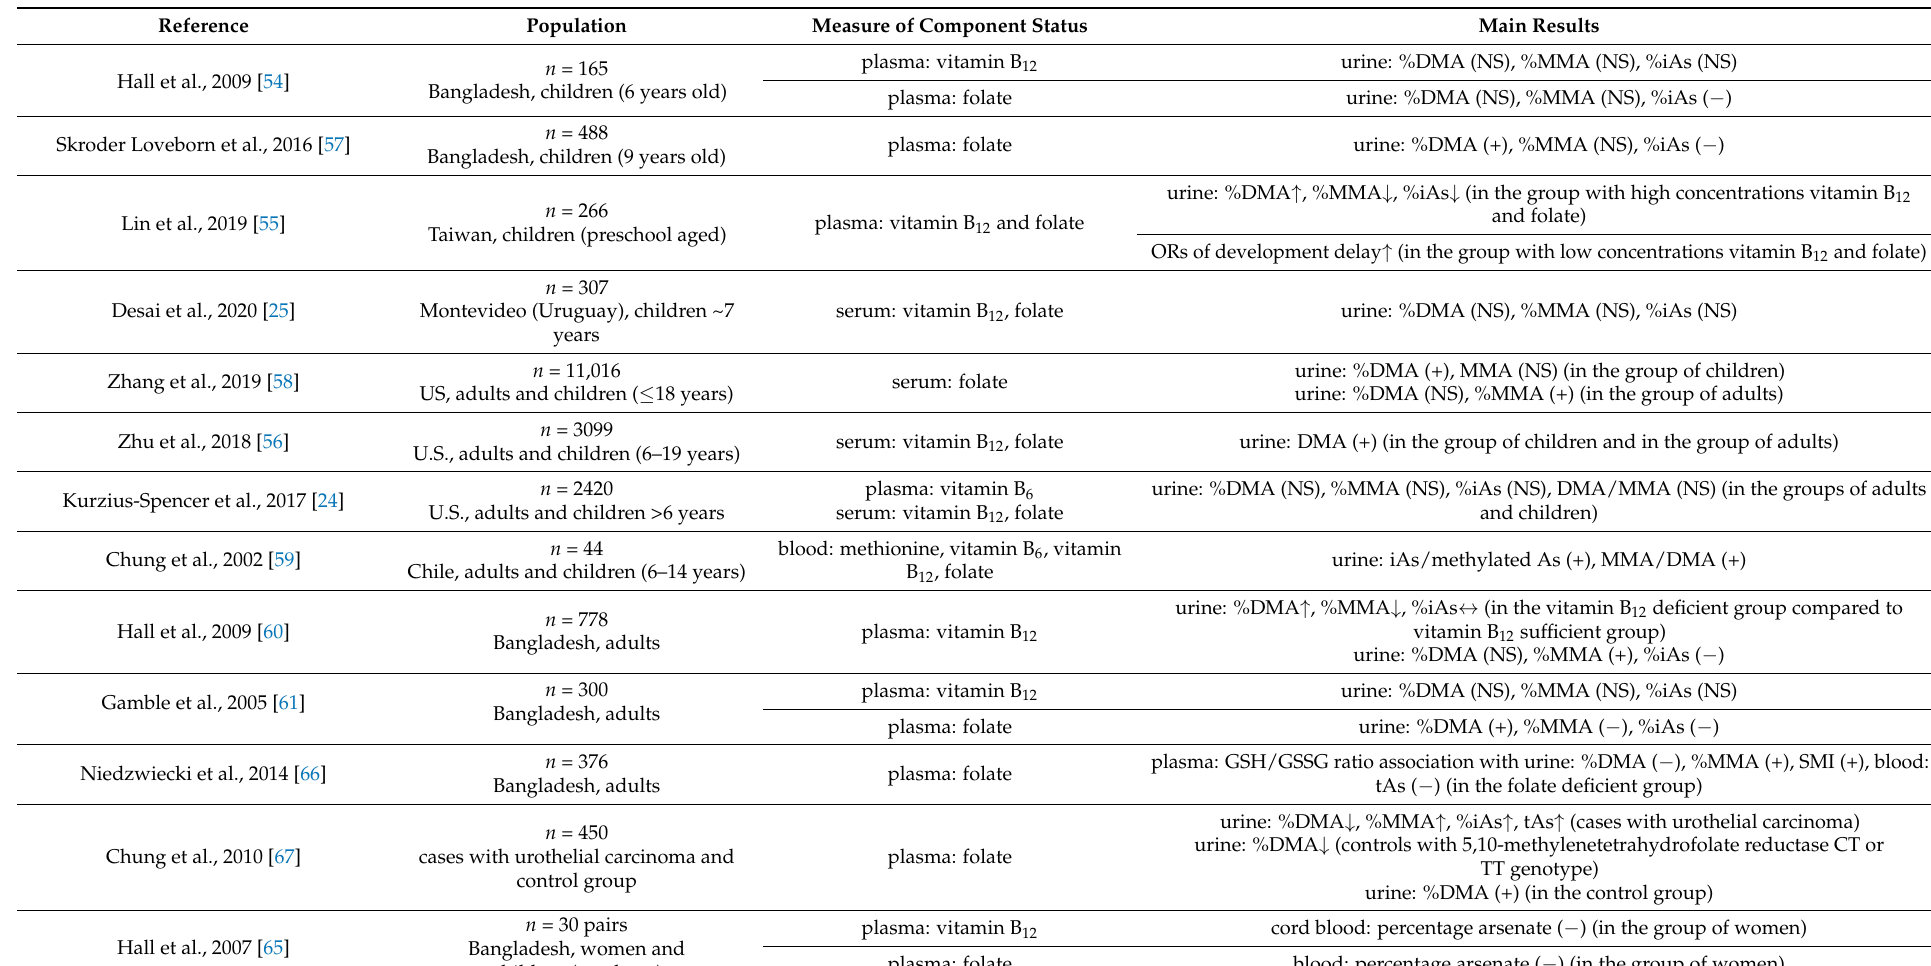
Table 4. Relationship between concentration of dietary compound in blood and other tissues and iAs metabolism and health effects related to As